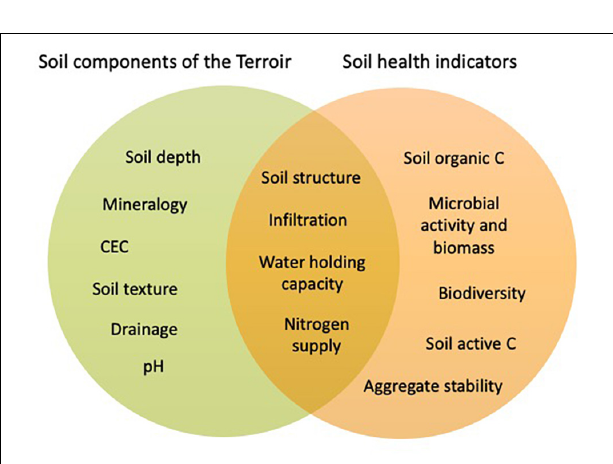
FIGURE 2 | Venn diagram illustrating where soil health and terroir